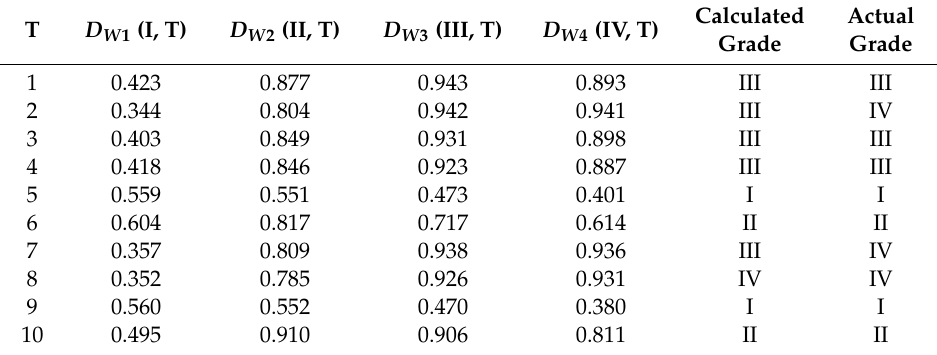
Table 9. The calculated stability grades for the slopes of group B using weight vectors determined by five samples.